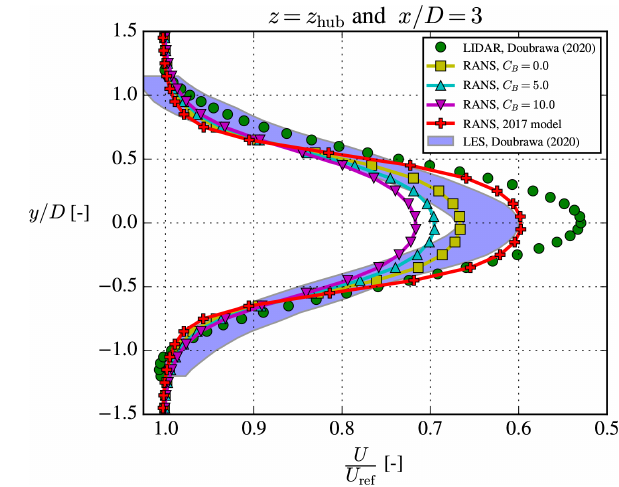
Figure 10. The unstable SWiFT case. The fixed frame of reference experimental and LES results were digitized from Doubrawa et al.